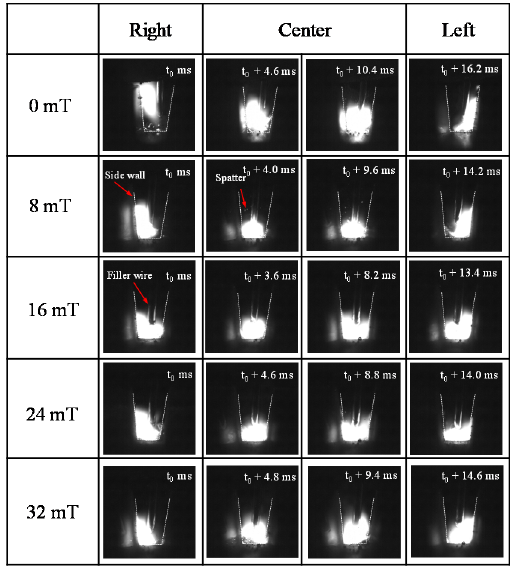
Figure 3. Arc shape under different magnetic intensity with a fixed frequency of 20 Hz.